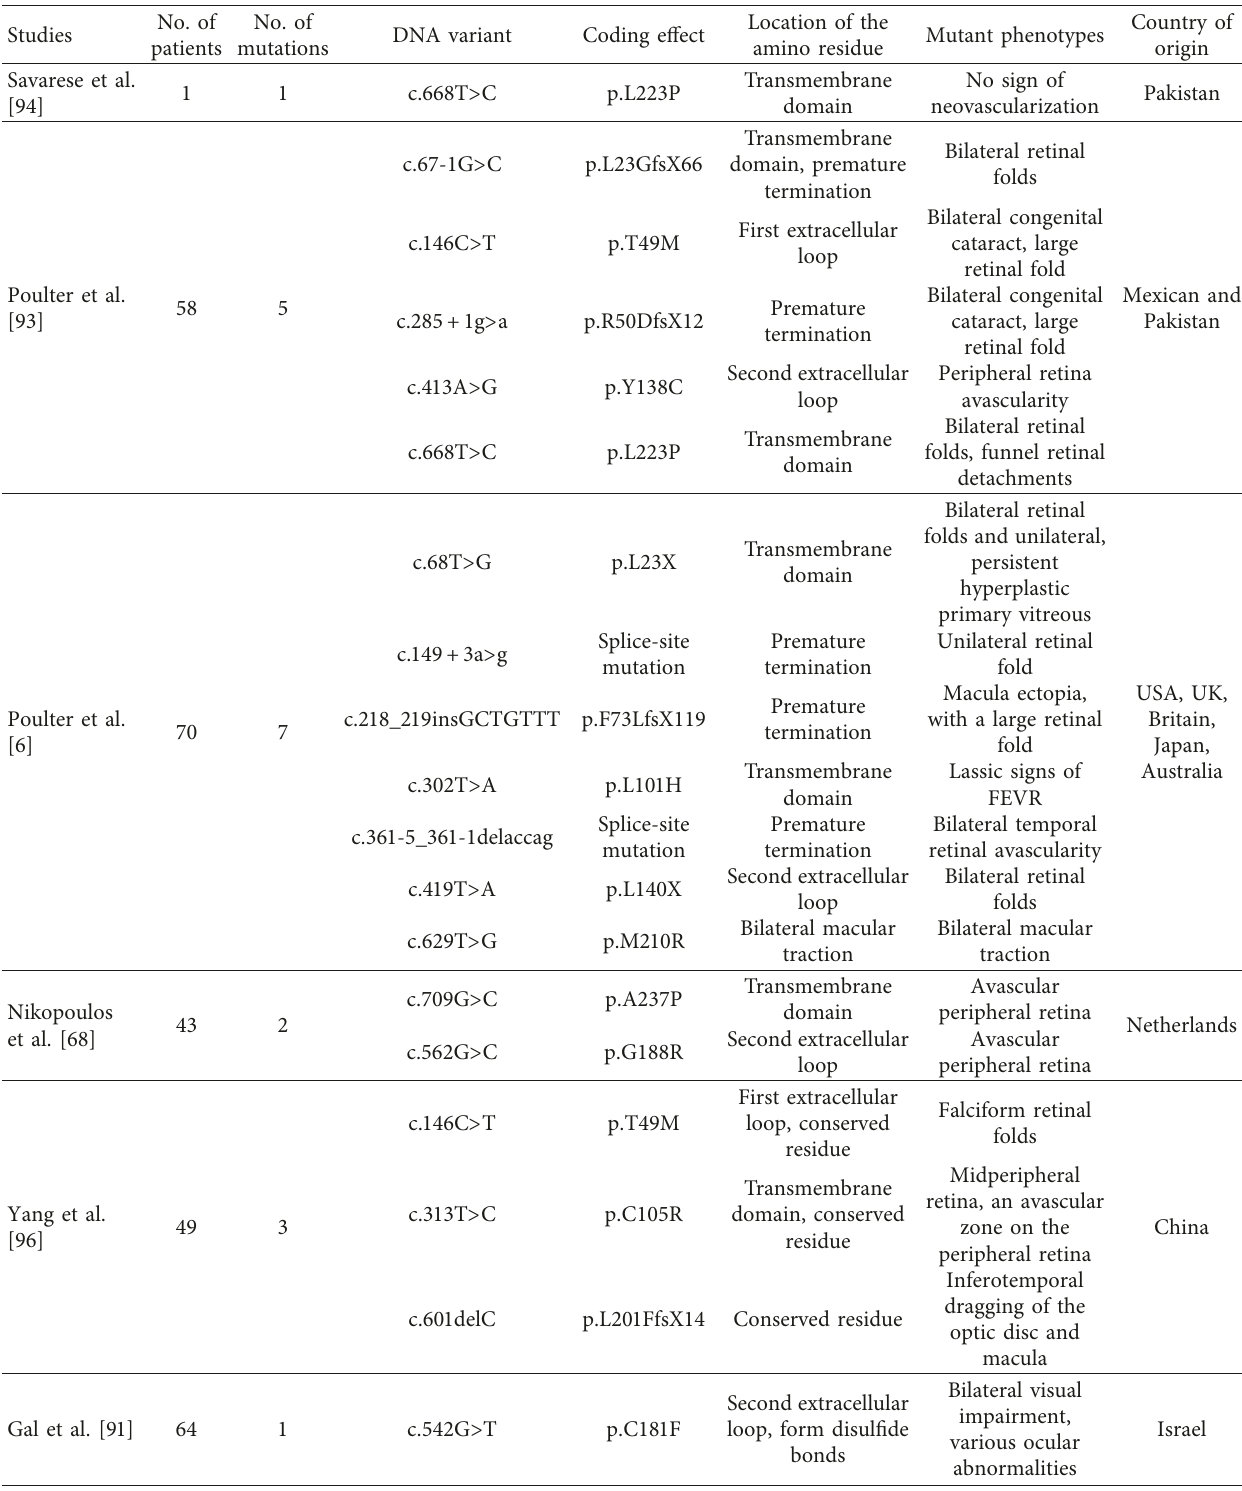
Table 4: Spectrum of TSPAN12 gene mutations among patients with familial exudative vitreoretinopathy.